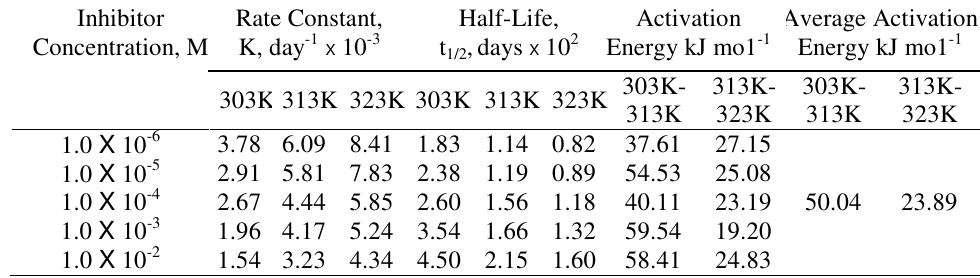
Table 3. The kinetic data for mild steel in 2 M HCl solution containing pyridoxol hydrochloride at different